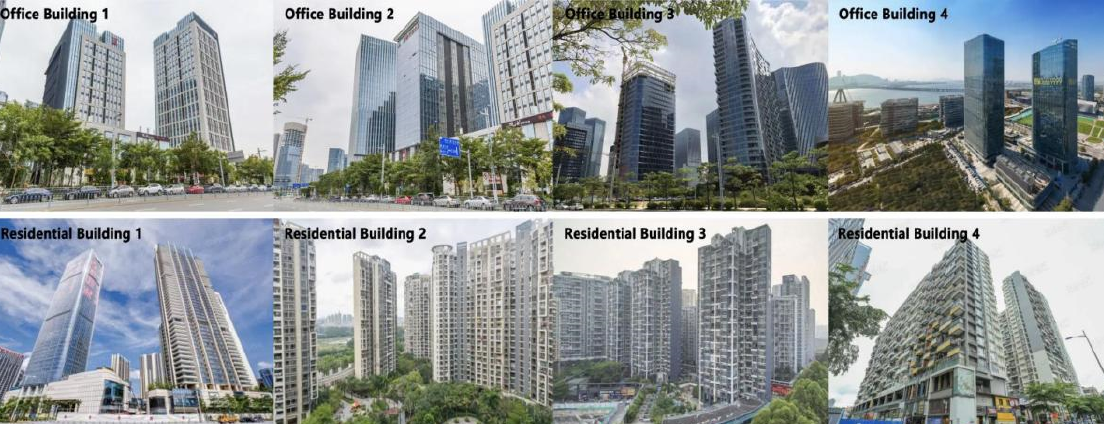
Figure 3. Typical office and residential building in Bao’an district. The figure belongs to the follow- ing source: Beike Housing. Available online: https://bj.ke.com (accessed on 18 August